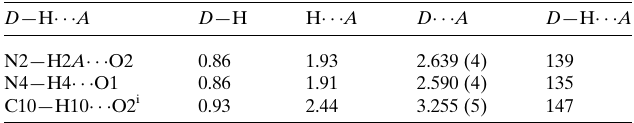
Table 1 Hydrogen-bond geometry (A˚ , (cid:2) ).